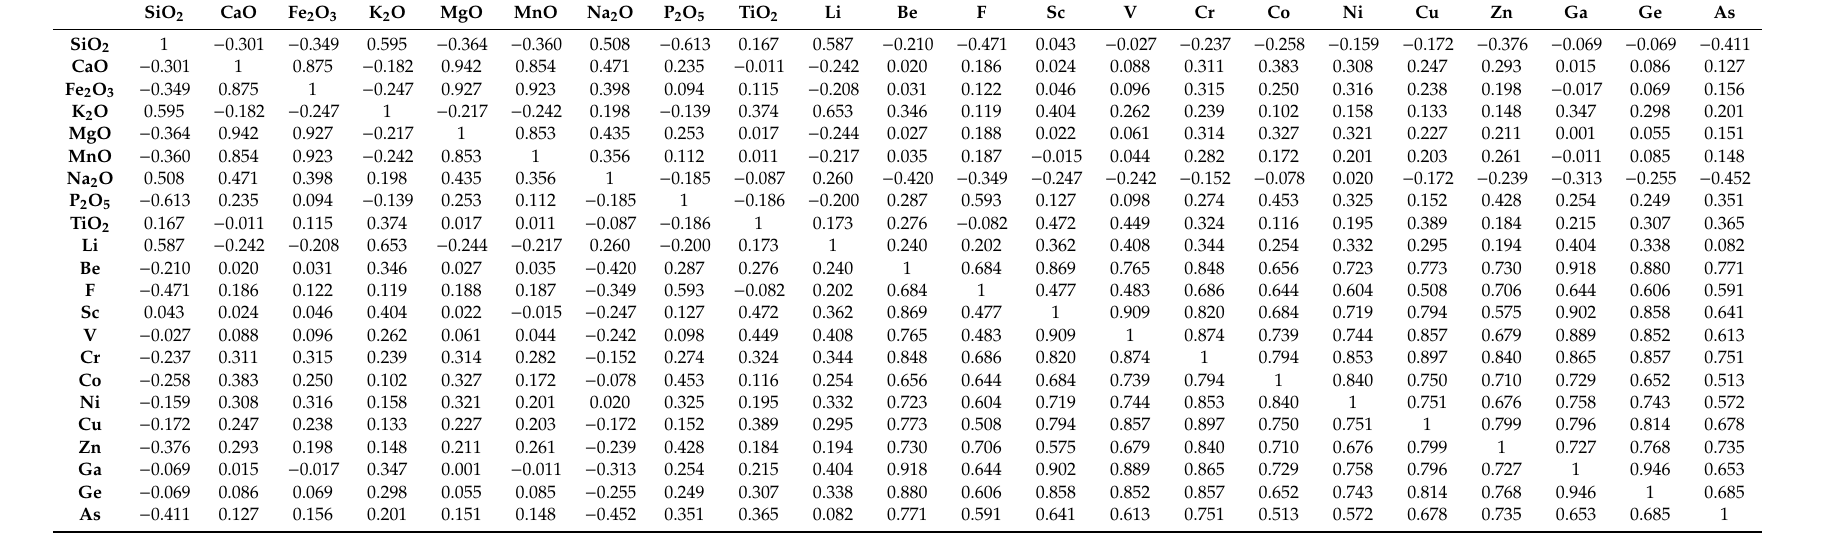
Table 6. Correlation using the impoved alr on coal and ash basis (Adaohai